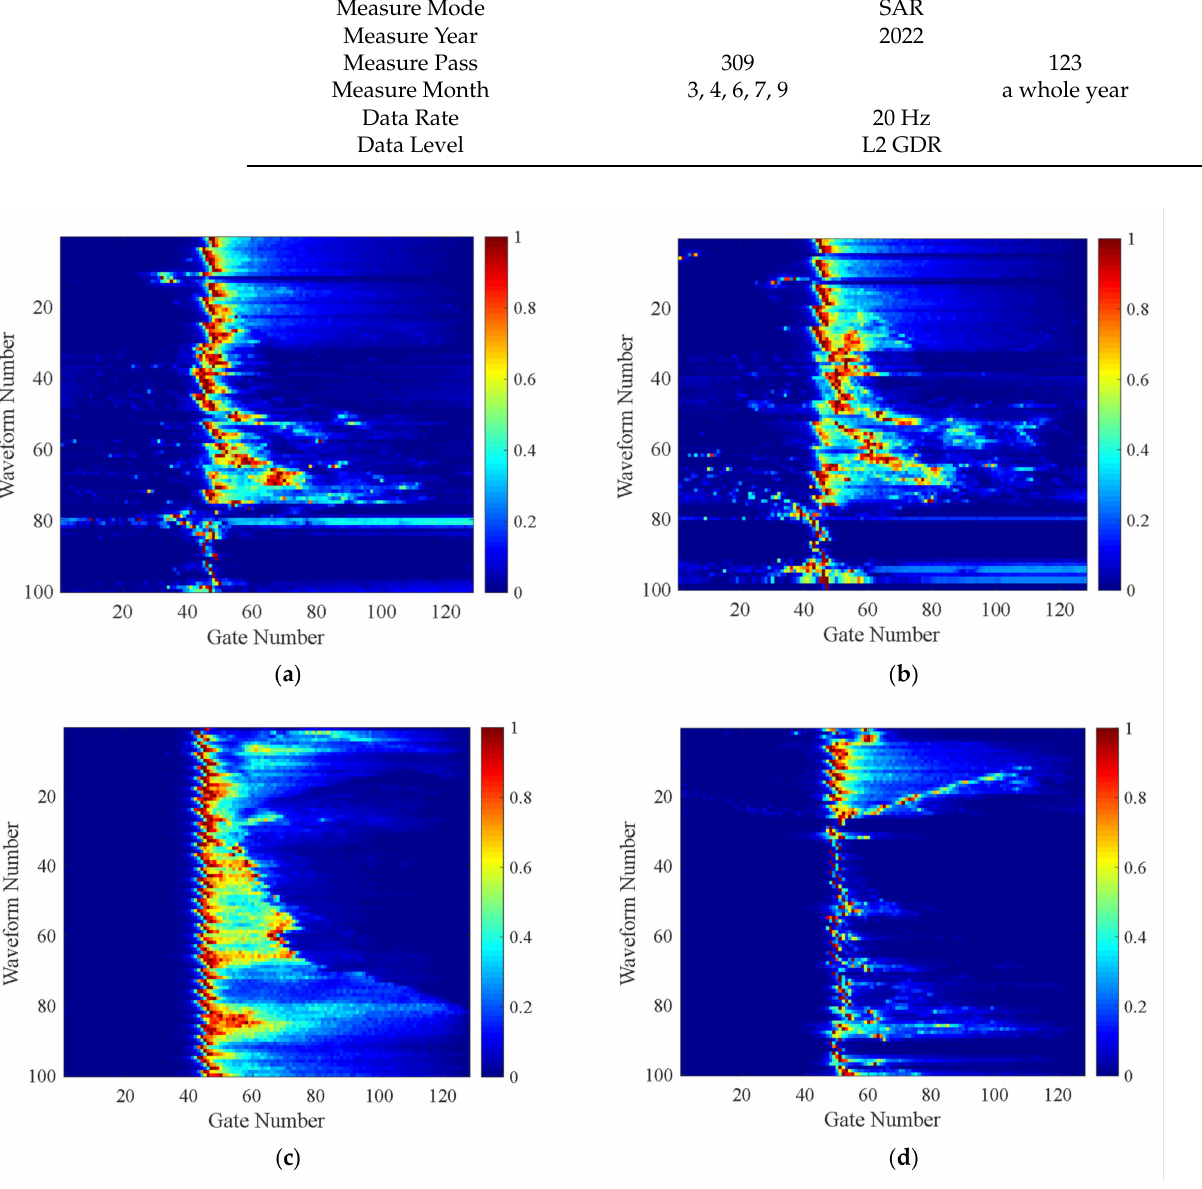
Figure 2. Normalized coastal waveforms of experimental area 1 in ( a ) June and ( b ) September. Normalized coastal waveforms of experimental area 2 in ( c ) May and ( d )